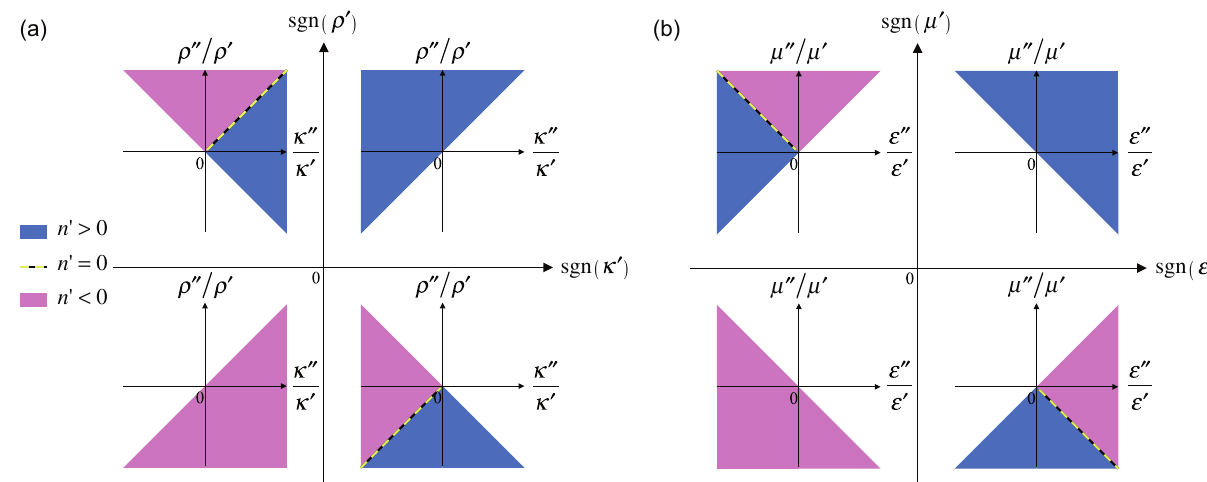
Figure 1. Diagrams identifying the sign of the refractive index according to the signs of the real and imaginary parts of the constitutive parameters. Blue (dark) areas refer to positive-index dissipative media ( n 0 > 0 and n 00 > 0) supporting forward waves, while pink (light) areas refer to negative-index dissipative media ( n 0 < 0 and n 00 > 0) supporting backward waves. White areas refer to amplifying media ( n 00 < 0) that are not considered here [17]. (a) Diagram for acoustic metamaterials with complex-valued bulk modulus j (= j 0 + i j 00 ) and mass density q (= q 0 + i q 00 ). (b) Diagram for electromagnetic metamaterials with complex-valued relative permittivity e (= e 0 + i e 00 ) and relative permeability l (= l 0 + i l 00